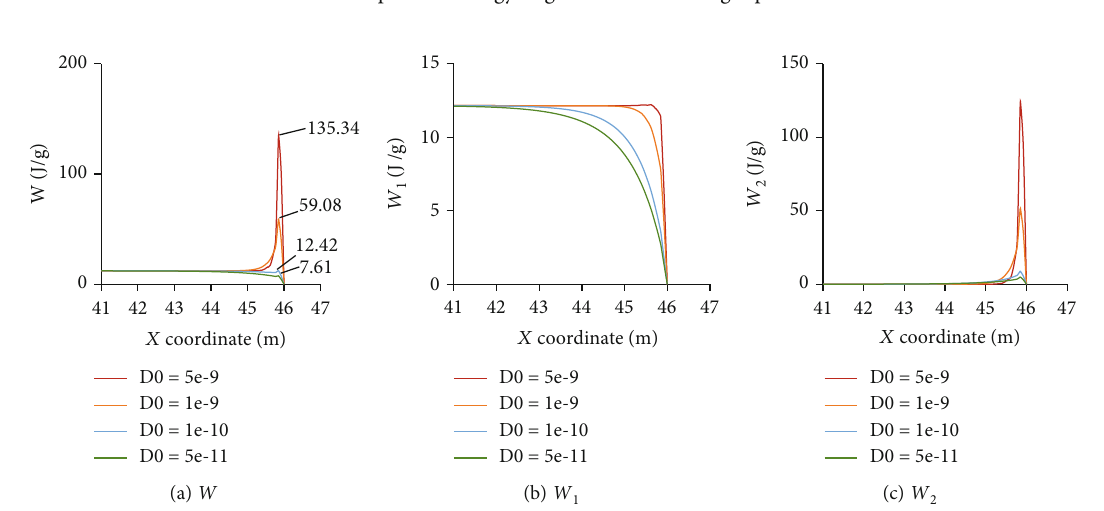
Figure 5: Expansion energy of gas under di ff erent gas pressures.